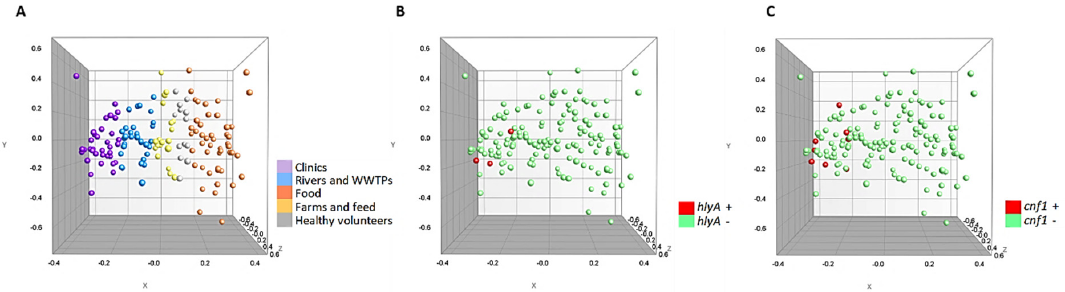
Figure 2. Multidimensional scaling graphs (MDS) for the 150 strains. ( A ) According to origin; ( B ) hlyA positive and negative strains ( C ) cnf1 positive and negative strains.